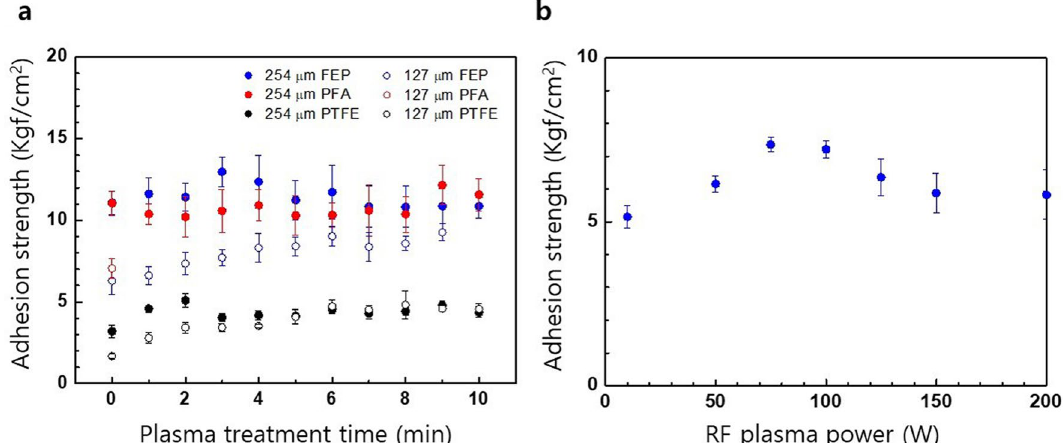
Figure 4. ( a ) The AS between Au and fluoropolymers relative to both the plasma treatment time and the fluoropolymer film thickness. Fluoropolymers were treated at an RF power of 40 W under working pressure of 15 mTorr. ( b ) Effect of RF sputtering power on the AS between Au and a non-treated 127-μm thick FEP film. RF sputtering power was applied in a two-step mode. Up to a nominal thickness of 20 nm, RF power in the range of 20–200 W was applied; afterward the RF power was switched to 50 W and maintained up to a nominal thickness of 200 nm. The RF sputtering power denotes that applied during the first